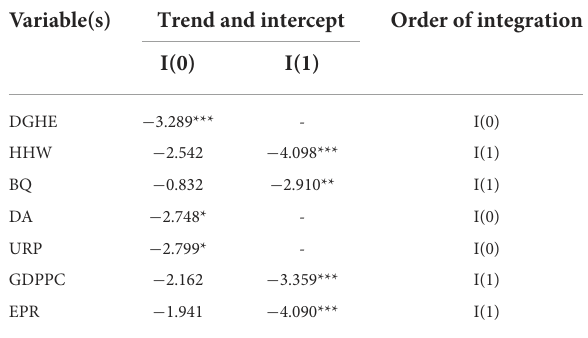
TABLE 4 Unit root testing (46).